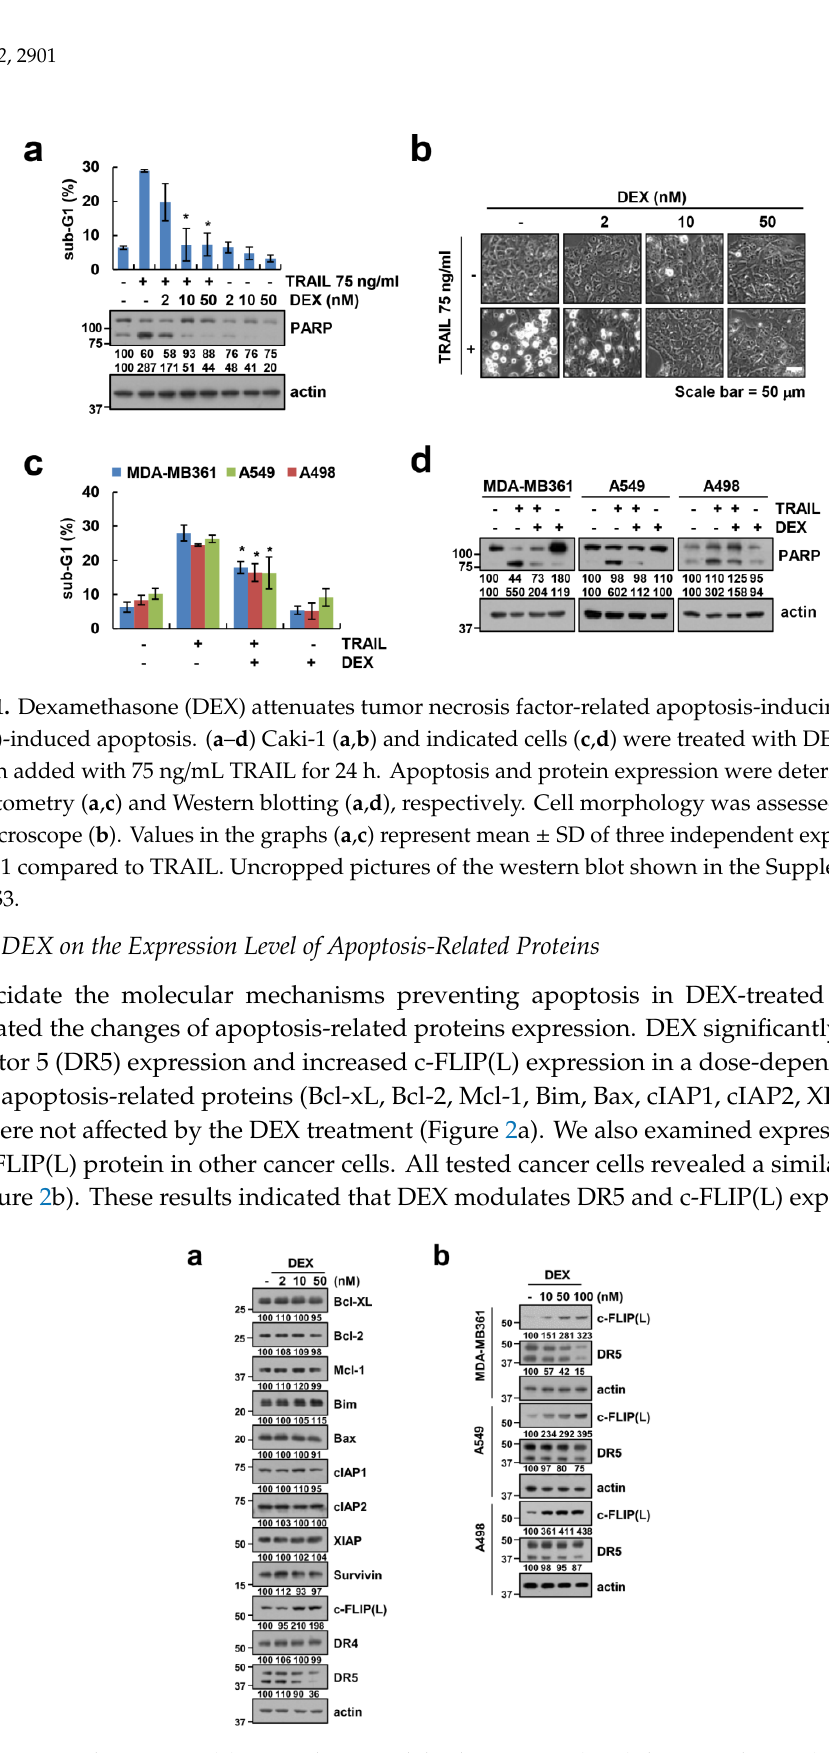
Figure 2. DEX induces c-FLIP(L) upregulation and death receptor 5 (DR5) downregulation. ( a , b ) Caki-1 cells ( a ) and indicated cells ( b ) were treated with DEX for 24 h. Protein expression was determined by Western blotting ( a , b ). Uncropped pictures of the western blot shown in the Supplementary Figure 4.